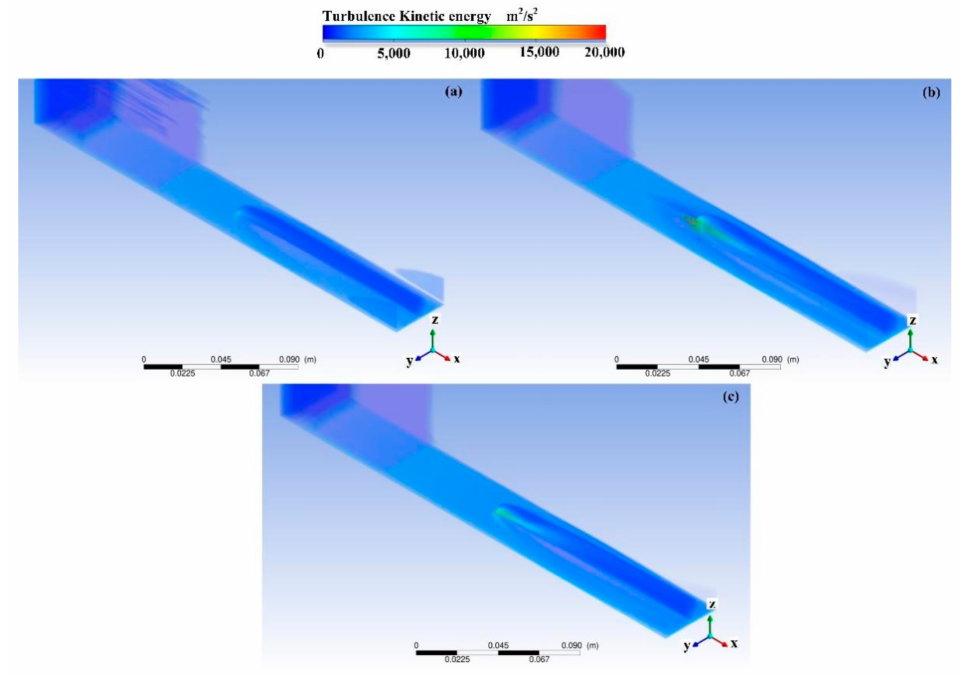
Figure 12. Turbulent kinetic energy volume rending diagrams for ( a ) Case a, ( b ) Case b, and ( c ) Case c.